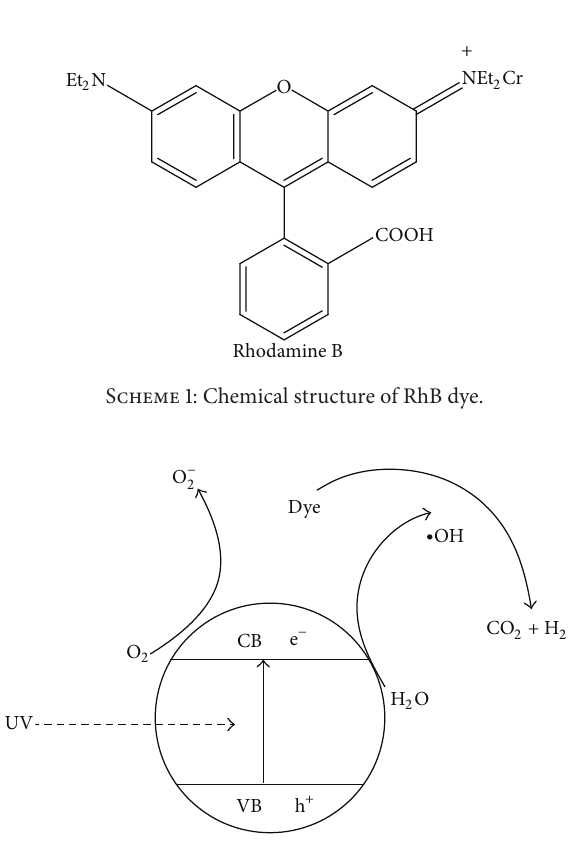
Scheme 2: The photocatalytic mechanism of ZnWO 4 under UV